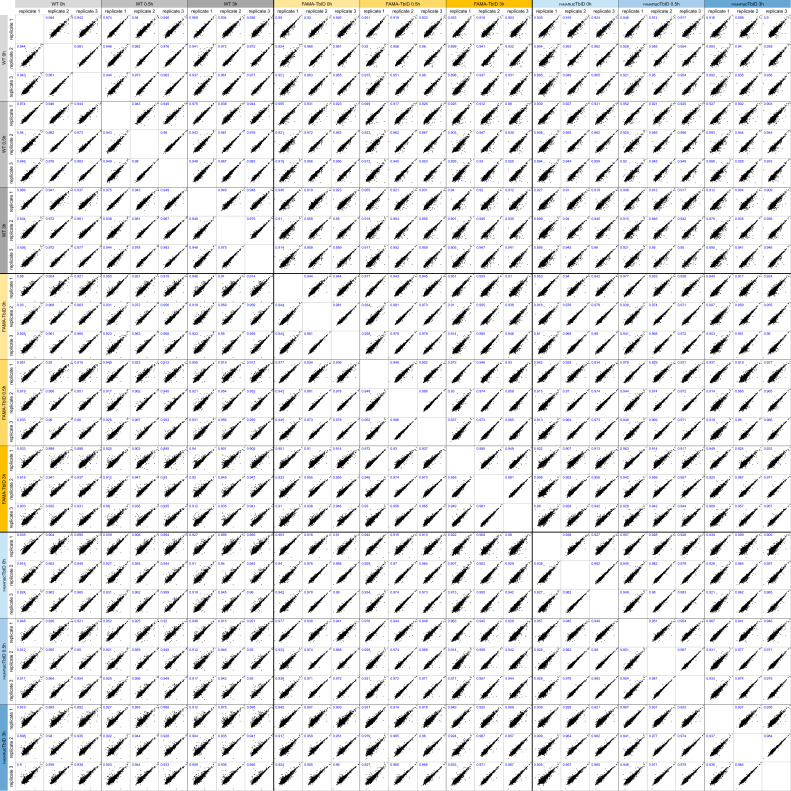
Multi scatter plot of samples for the ‘FAMA interactome’ PL experiment.Proteins that were identified in all three replicates of at least one time point of one genotype were used for a multi scatter plot. For each pair-wise comparison, LFQ values of individual proteins in sample A (labeled on top, x-axis) and sample B (labeled on the left, y-axis) are plotted against each other. Plots are scaled equally. Pearson correlation coefficients for each comparison are given in the upper left corner of the plots in blue.